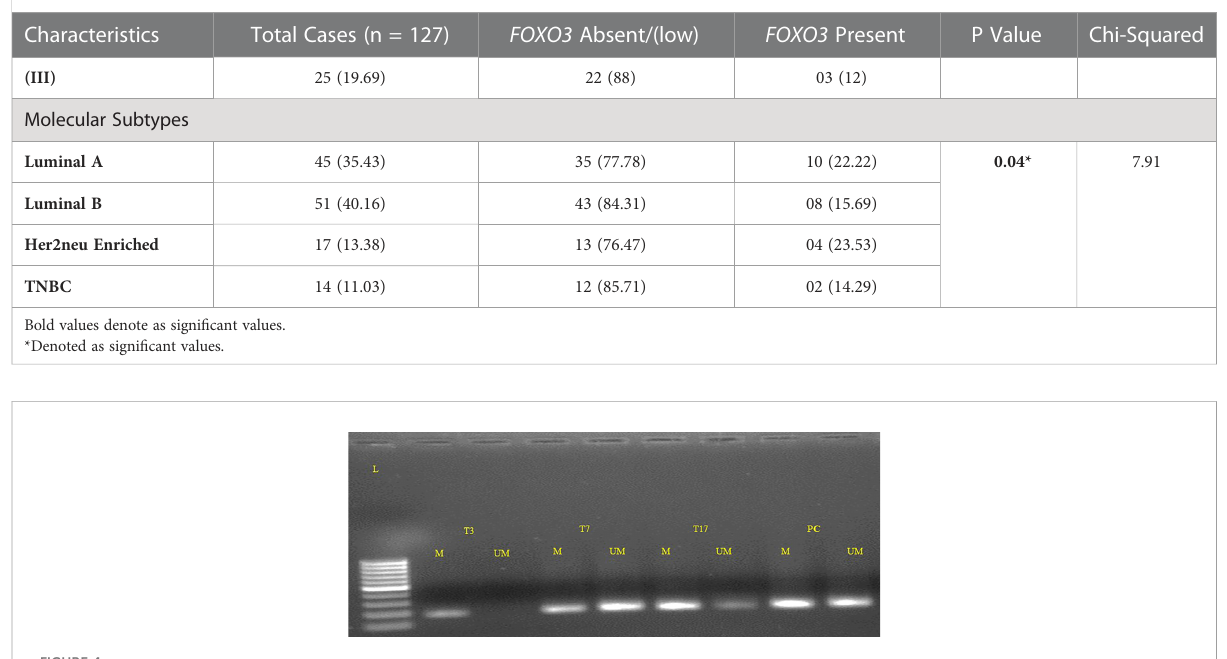
FIGURE 4 Representative gel picture of Methylation-speci fi c PCR analysis of FOXO3 gene in Breast cancer patients: DNA methylation was assessed using two speci fi cally designed primers to amplify either methylated DNA (M, 210bp.)) or unmethylated DNA (UM, 212bp.) (L: 100 bp DNA ladder; number indicates the case number; PC, Positive control; T: tumor